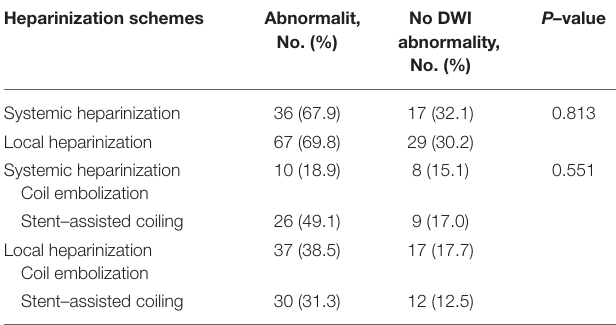
TABLE 2 | Grouping of the heparinization schemes and analysis of cerebral ischemia.